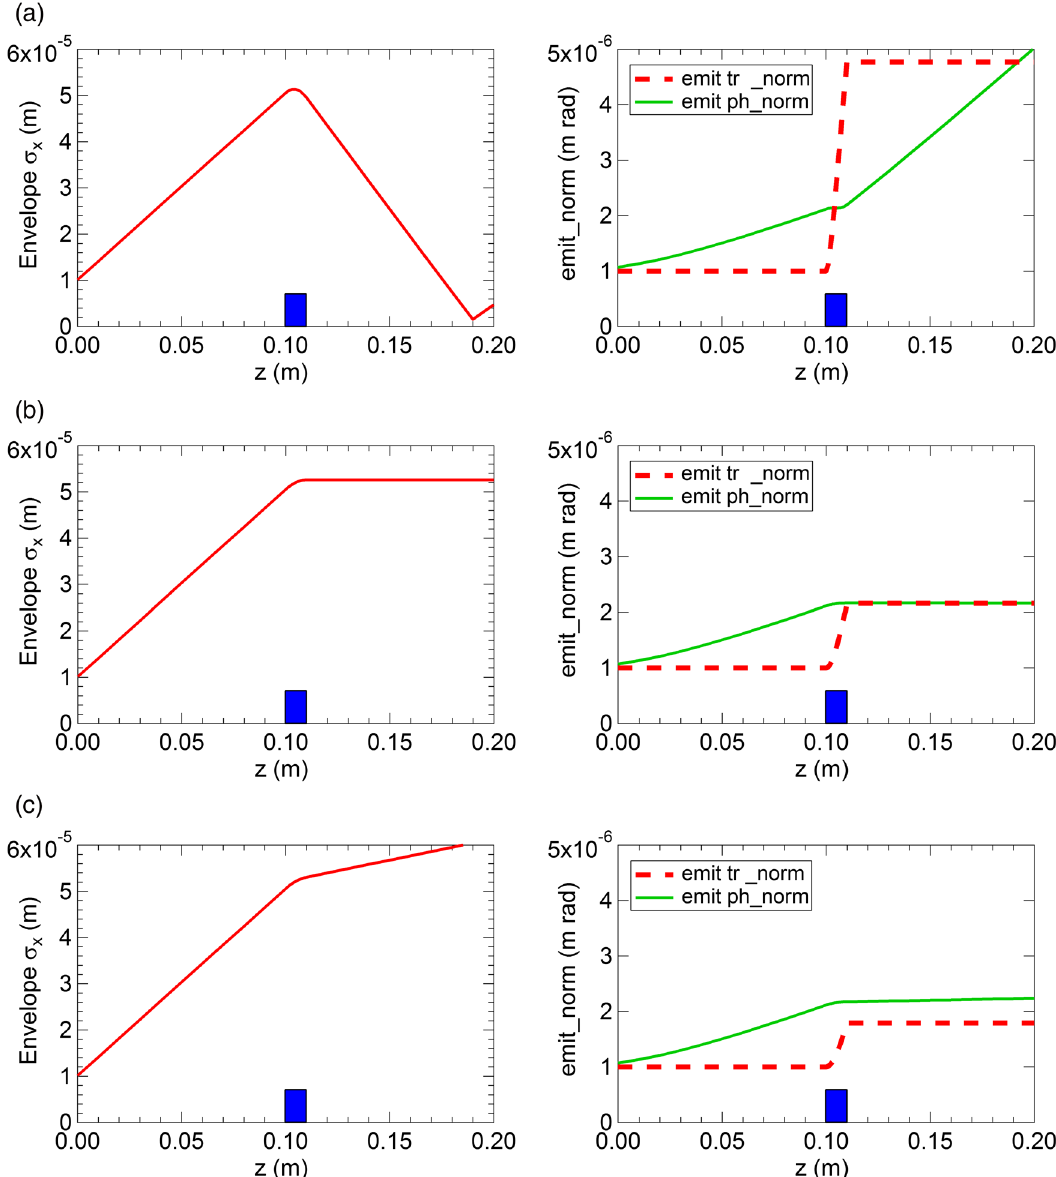
FIG. 1. Variation of beam size (left), normalized phase and trace emittance (right) along a structure including a 0.1 m free drift, followed by a 0.01 m quadrupole (blue rectangle in the graphs) and a second drift. The cases of three different quadrupole strengths are shown from top to bottom: 330 (a), 130 (b), and 100 T (c), the second one being chosen for obtaining a parallel beam after